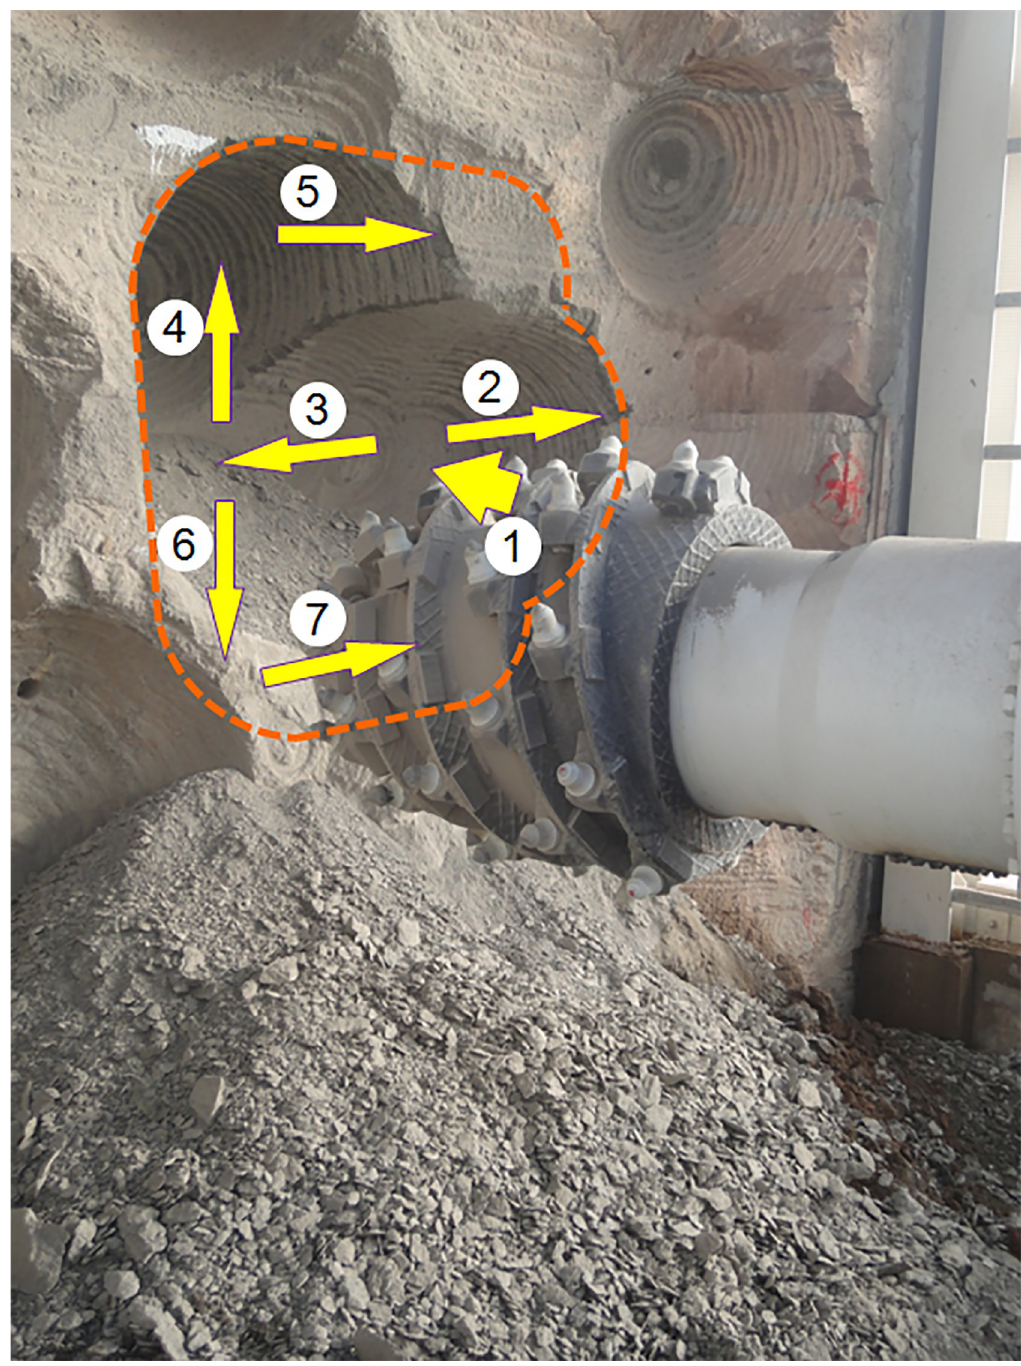
Fig 24. Artificial rock wall cutting test with EBZ260W